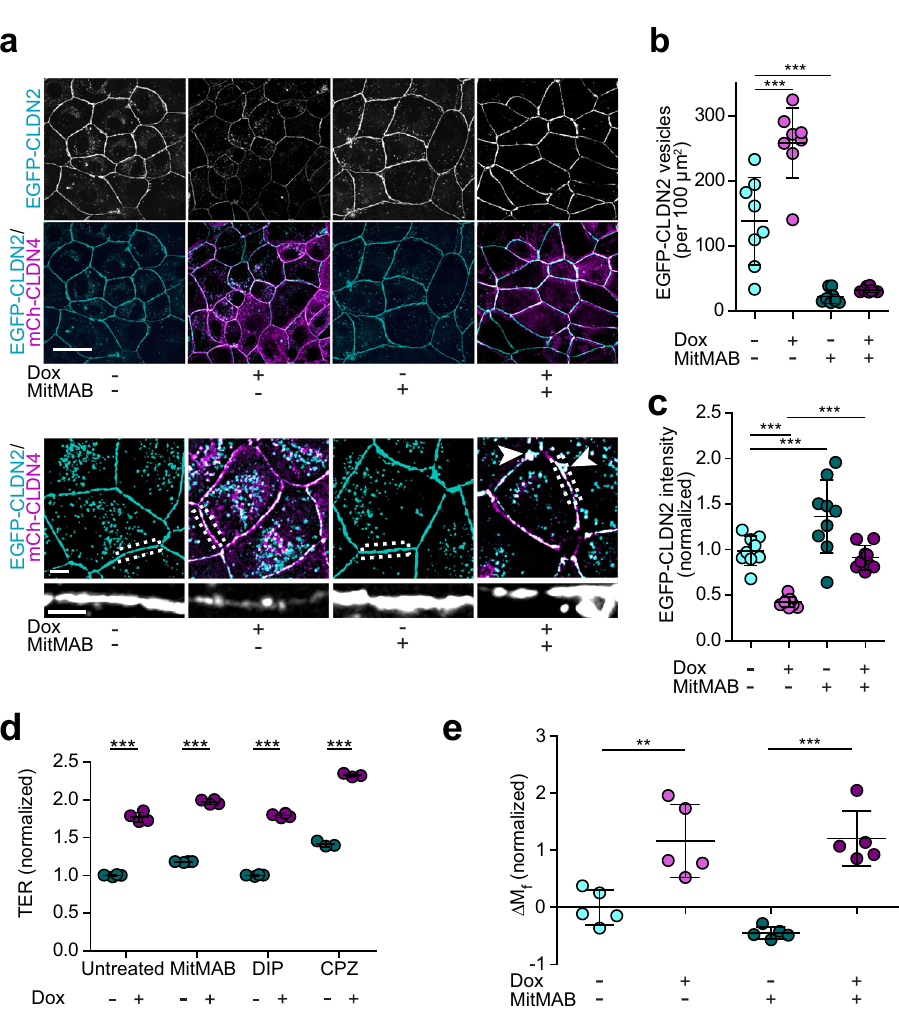
Fig. 9 Endocytic inhibition prevents claudin-2 internalization but not channel mobilization or inactivation. a The dynamin inhibitor MiTMAB (20 μ M) prevents EGFP-claudin-2 (cyan) removal from tight junctions following induction ( + Dox) of mCherry-claudin-4 (magenta) expression.